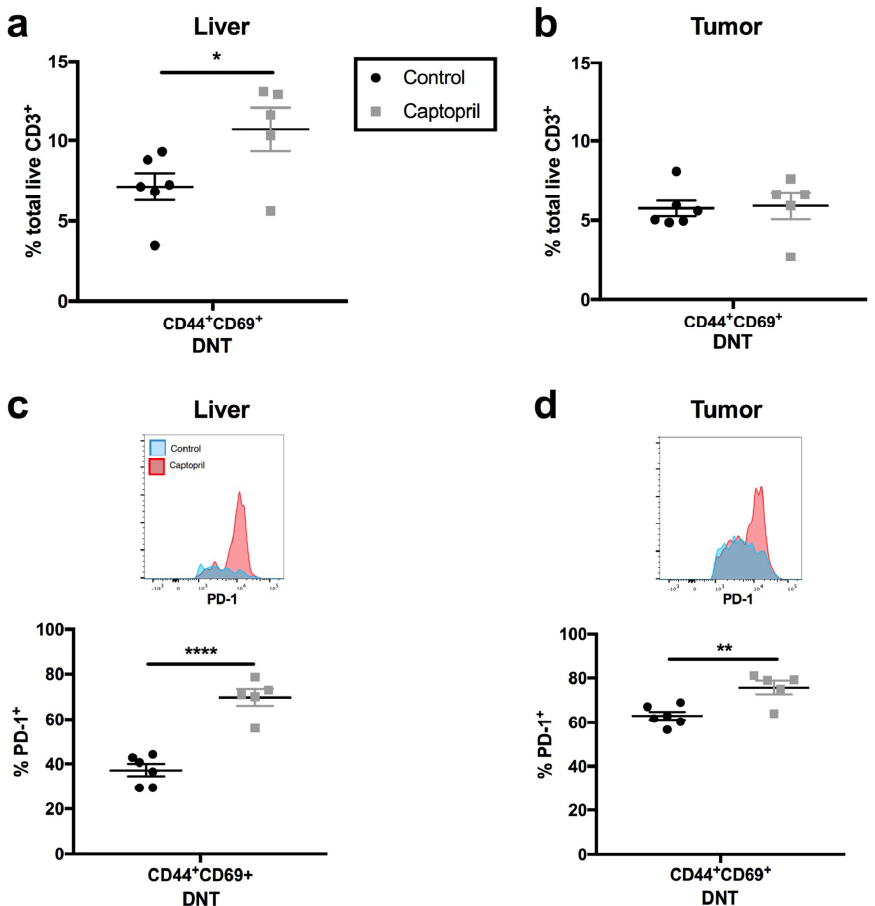
Figure 3. The renin–angiotensin system inhibitor (RASi) captopril increases the expression of the immune regulator PD-1 on tissue-resident memory (T RM )-like DNT cells in regenerating liver and tumour. Mice underwent colorectal liver metastasis tumour induction and were treated with either control (saline) or RASi captopril. From Day 4 to Day 16, intraperitoneal injections of captopril 250 mg/kg/day or saline (control) were administered. On Day 7, mice underwent a 70% partial hepatectomy. Mice were culled on Day 16, and liver and tumour specimens were retrieved for flow cytometry: ( a , b ) proportion of total CD3 + T lymphocytes that were DN T T RM -like (co-expressing CD44 + /CD69 + ) in liver ( a ) and tumour ( b ); ( c , d ) percentage of PD-1 + T RM -like DN T lymphocytes and insets of concatenated histograms of PD-1 fluorescence intensity on T RM -like DN T lymphocytes in liver ( c ) and tumour ( d ). Data are representative of a single murine experiment (control n = 6 mice, captopril, n = 5 mice). Significant differences were determined by the unpaired, two-tailed Student’s t -test. p < 0.05 (*), p < 0.01 (**), p < 0.0001